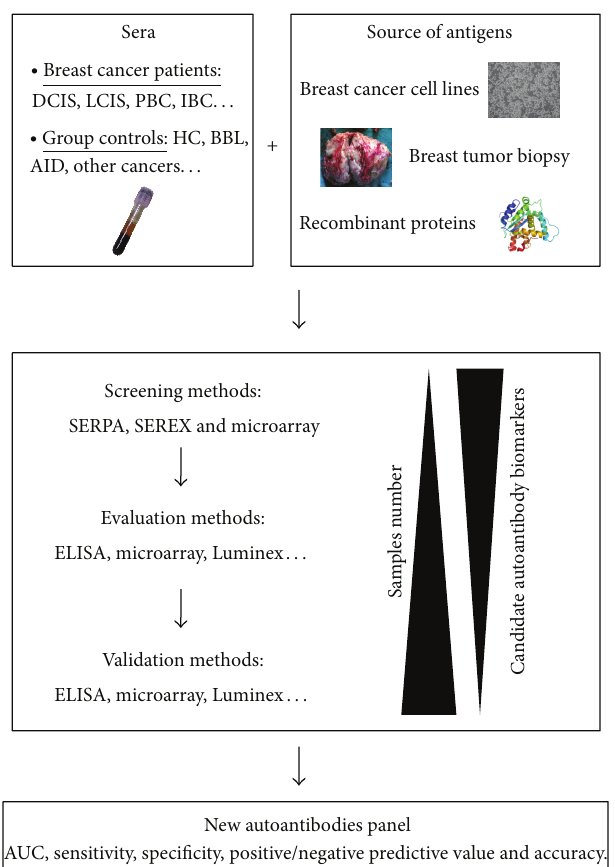
Figure 1: Breast cancer autoantibody research pipeline. Methodologies for identification of TAAs consist to locate specific immunogenic proteins specific from a source of antigens (recombinant protein or extracted from cell cultures or tumors). Different screening methods have been developed in order to identify TAAs such as SEREX (serological identification of antigens by recombinant expression cloning), SERPA (serological proteome analysis), or more recently microarray. TAAs were subsequently evaluated and validated using ELISA on multiplex methodologies such as Luminex or microarray. DCIS (ductal carcinoma in situ ); LCIS (lobular carcinoma in situ ); PBC (primary breast cancer); IBC (invasive breast cancer); HC (healthy control); BBL (benign breast lesions); AID (autoimmune disease); AUC (area under